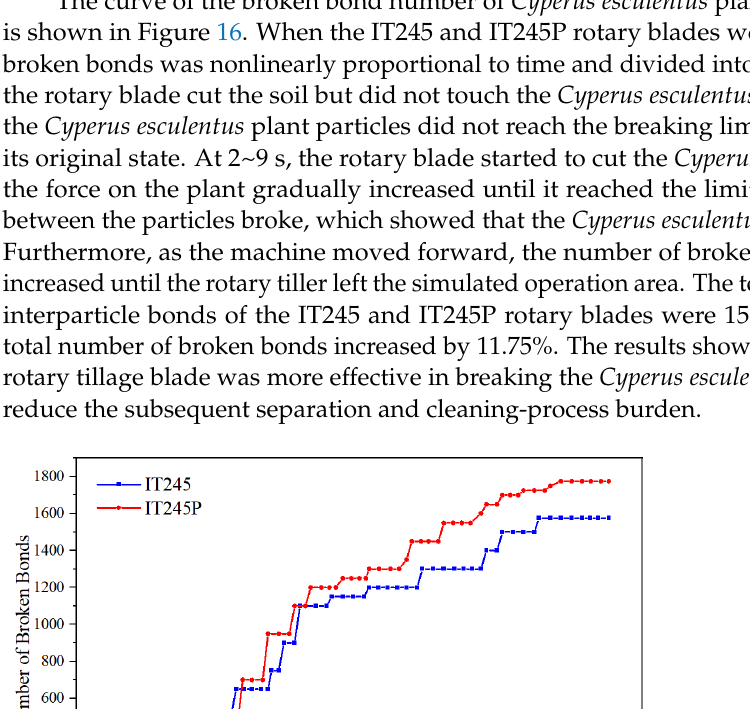
Table 6. Experimental protocol and results.